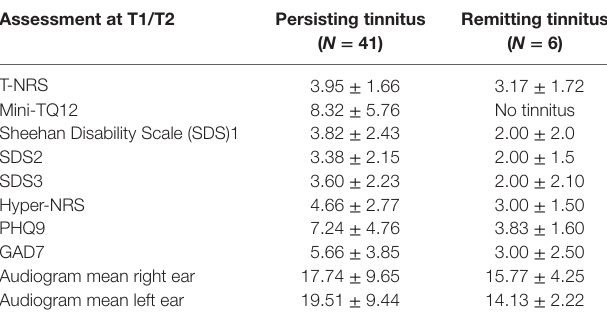
TaBle 2 | Comparison of subgroups with persisting and remitting